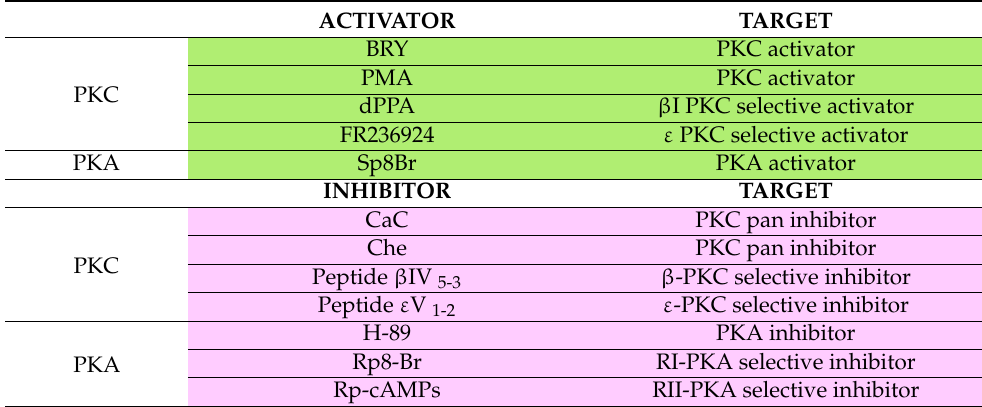
Table 1. PKC and PKA activators and inhibitors and their